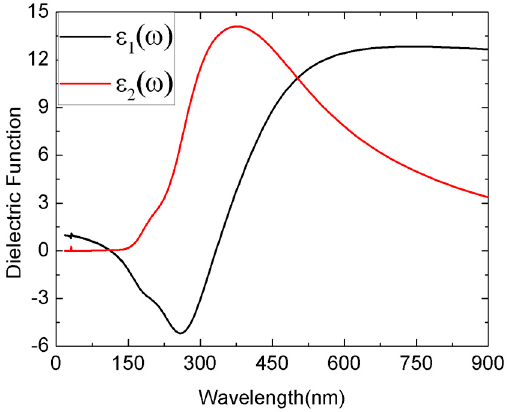
Figure 4. The complex dielectric function for the TcP 4 crystal; the black solid line corresponds to the real part, and the red solid line corresponds to the imaginary part. Crystals 2017 , 7 , 176 7 of 10